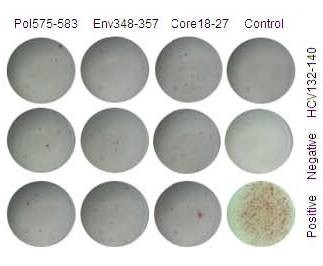
ELISPOT results from AHB patients. Sequence of Pol575-58 is FLLSLGIHL, sequence of Env348-357 is GLSPTVWLSV, sequence of Core18-27 is FLPSDFFPSV, sequence of HCV Core132-140 is DLMGYIPLV; all are HLA-A0201 limited. Medium without stimulation or cells was used for negative control, PHA for positive control. 2 × 10E5 cells per well was used for the negative and peptide stimulated groups, 1 × 10E4 cells per well was used for the positive control. The final concentration of peptide was 10 μg/ml, PHA 4 μg/ml. HLA-A0201 positive patients during the first week of hospitalization were chosen as the research subjects.